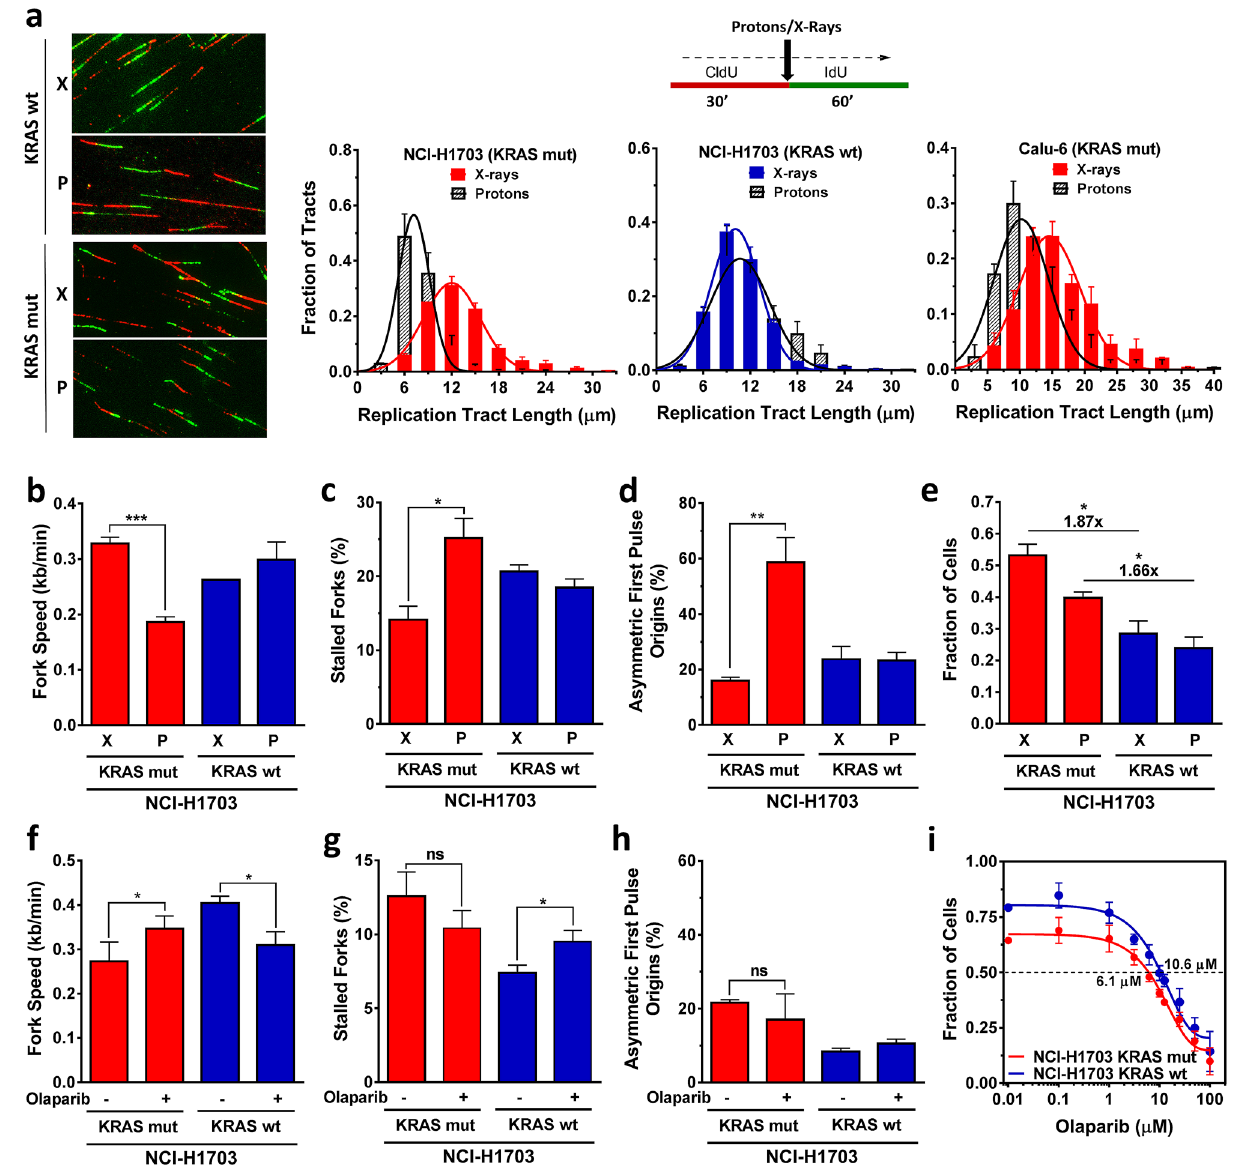
Figure 5. Cellular response of KRAS mutant (mut) and wild-type (wt) cancer cells to treatment with radiation or PARP inhibition (PARPi). ( a ) Left, representative images illustrating single DNA fibers following irradiation with 2 Gy X-rays (X) or protons (P) delivered in between pulse labels. Right, distribution of fiber length in irradiated KRASmut and wt cells. ( b–d ) Velocity of fork progression, percentage of stalled forks, and percentage of bidirectional asymmetric first pulse origins in isogenic cells irradiated with 2 Gy. ( e ) Fraction of cells surviving 5 days following irradiation with 6 Gy using a validated 3D viability assay 14 . ( f–h ) Velocity of fork progression, percentage of stalled forks, and percentage of bidirectional asymmetric first pulse origins in isogenic cells treated with/without PARPi olaparib (5 µM). ( i ) Fraction of cells surviving after 5 days of treatment with varying concentrations of olaparib. The drug concentration to achieve 50% cell survival (IC50) is indicated. All bars represent mean + /- SEM based on 2–3 independent repeats. Statistical comparisons by two- sided T-test indicating * p ≤ 0.05, ** p ≤ 0.01, *** p ≤ 0.001; ns, not